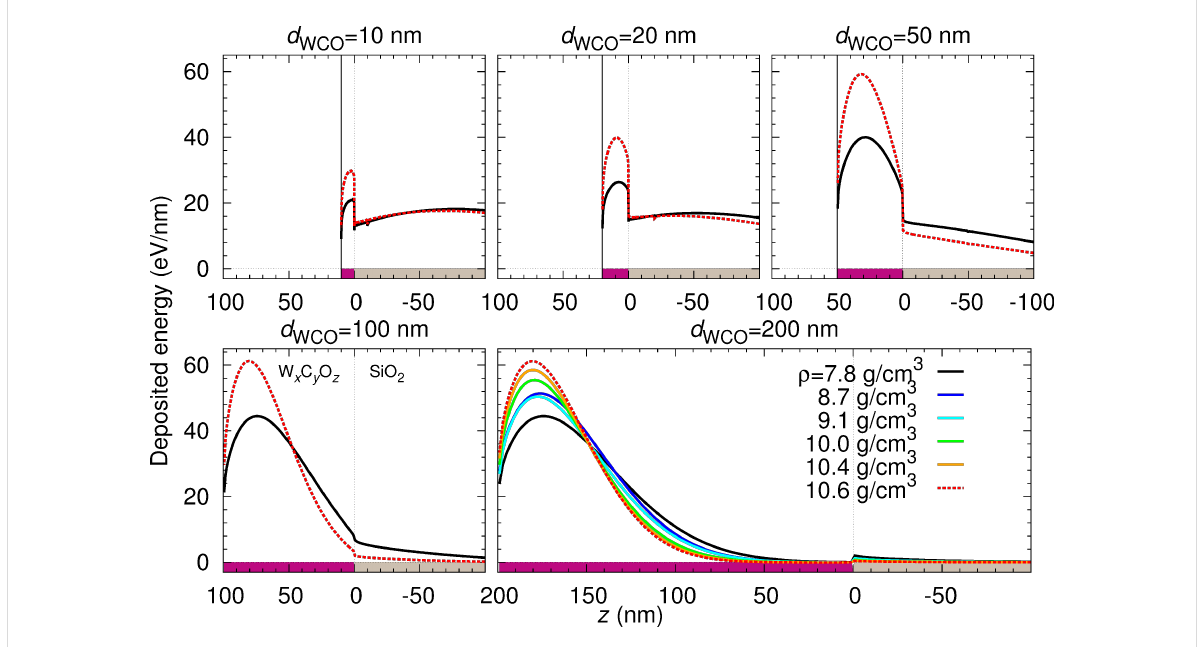
Figure 7: Energy deposited in the system as a function of the depth z for the indicated sample thicknesses d WCO and for the six nanostructure ma- terials specified in Table 1. The position z = 0 corresponds to the deposit-substrate interface; the position z = d WCO (indicated by a solid vertical line in the three upper panels) corresponds to the deposit-vacuum interface. Notice that, in addition to the density, the composition of the samples varies (see Table 1).